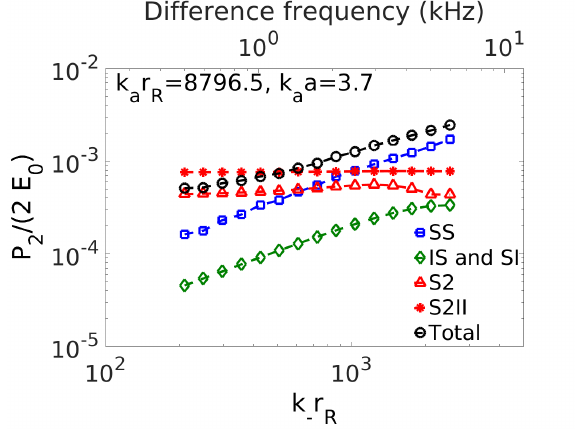
Figure 12. Same as Figure 11 but for herring at 100 m depth with equivalent bubble radius of 0.80 cm.